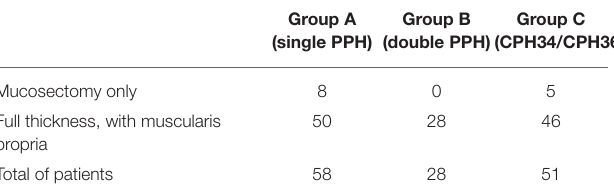
TABLE 1 | Histopathological study of the rectal ring, after SH (137 patients).